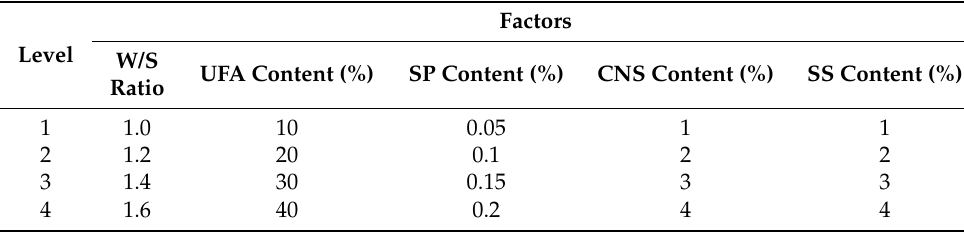
Table 3. Five factors and four levels of orthogonal test design.